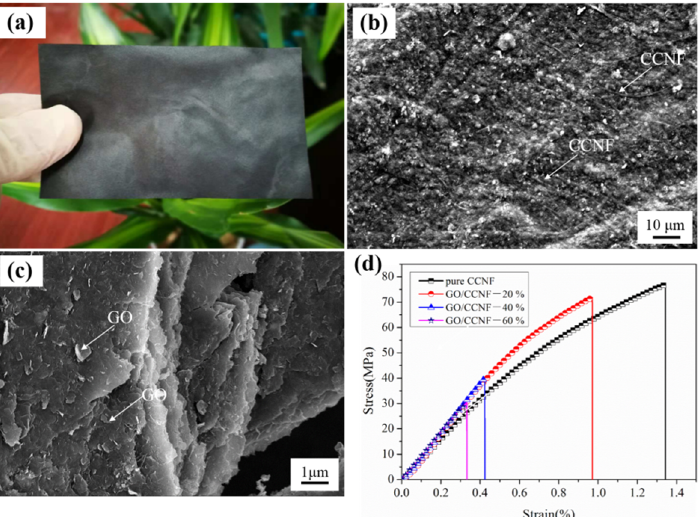
Figure 2. Mechanical properties and microstructure of GO/CCNF films. ( a ) sample photograph; ( b ) surface SEM image; ( c ) tensile section SEM image; ( d ) stress–strain curves.